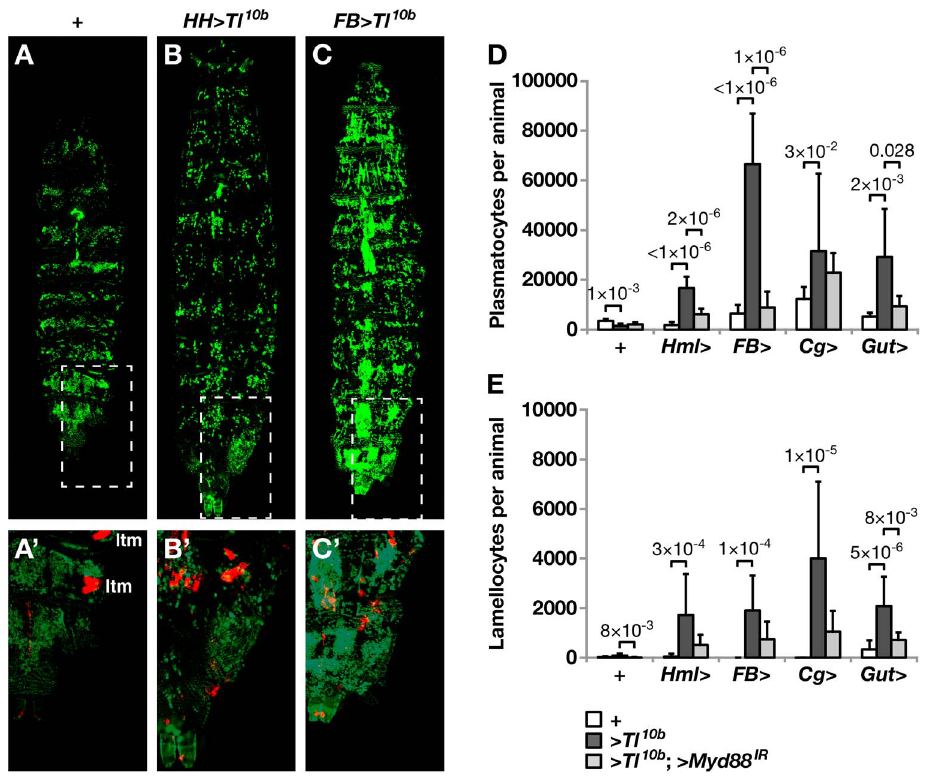
Figure 1. Forced Toll signaling in several different tissues triggers a hemocyte response. The pattern of sessile cells in a control third instar larva ( A ), or after expression of UAS-Toll 10b ( . Tl 10b ) in hemocytes with the Hml D -Gal4 , He-Gal4 ( HH . ) double driver ( B ) or in fat body with the FB-Gal4 ( FB . ) driver ( C ). The total number of circulating plasmatocytes ( D ) and lamellocytes ( E ) is dramatically increased in the hemolymph of larvae when UAS-Toll 10b ( . Tl 10b ) is expressed with different drivers: in hemocytes by Hml D -Gal4 ( Hml . ), in fat body by FB-Gal4 ( FB . ), in hemocytes plus fat body by Cg-Gal4 ( Cg . ), and in intestine by NP 3084 -Gal4 ( Gut . ), compared to the w 1118 control ( + ). This effect was suppressed by co-expressing the UAS-MyD88 GD25399 RNAi construct ( . MyD88 IR ). In A-C, plasmatocytes were visualized with the eater-GFP reporter, and in A 9 -C 9 also lamellocytes with the msn-Cherry reporter, using ApoTome imaging. In the control larva (A 9 ) msn-Cherry is ectopically expressed in the lateral transverse muscles (ltm). In the Toll 10b -expressing larvae (B 9 , C 9 ), msn-Cherry fluorescence is mainly seen in the lamellocytes. Larvae of the genotype shown in (C) had to be kept at 26 u C, all other experiments were at 29 u C. The larvae are oriented with the anterior end up. In D and E the cell types were distinguished by morphology and their numbers were counted in hemolymph samples of 10 individual larvae per cross. The results are presented as the means + / 2 standard deviation and the significance levels were estimated by independent sample T-test (two-tailed) in D and Mann-Whitney U exact test (two- tailed) in